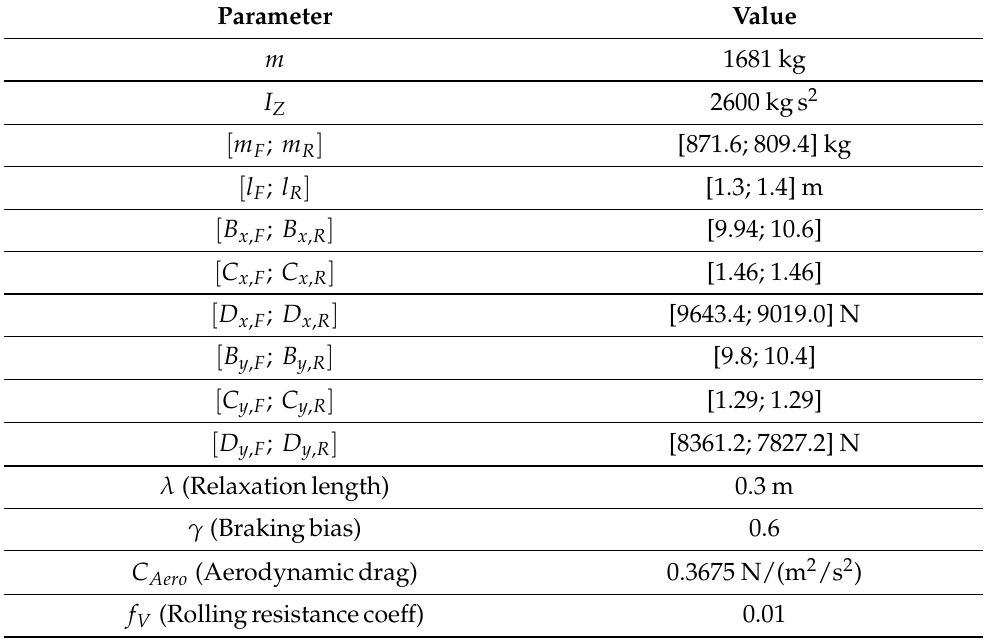
Table 1. Vehicle parameters for the single-track